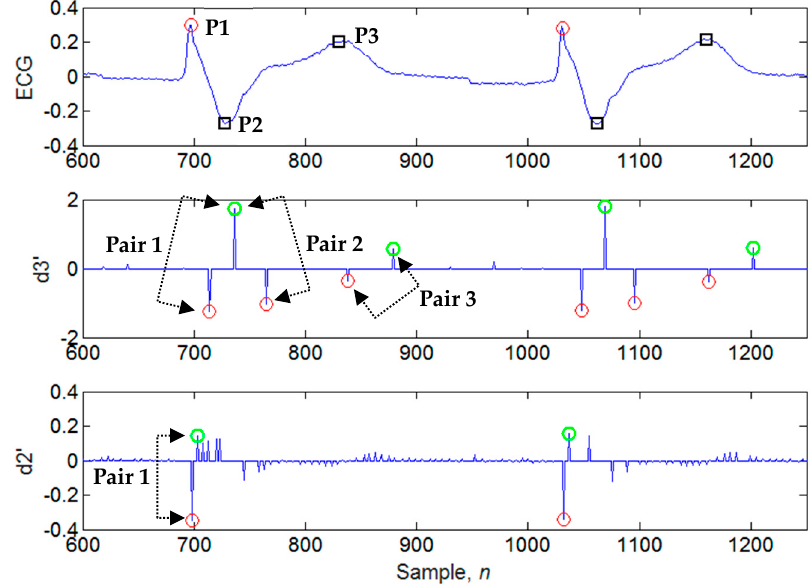
Figure 11. Illustration of the identifications of QRS peaks for Case 2.2 and Case 3.